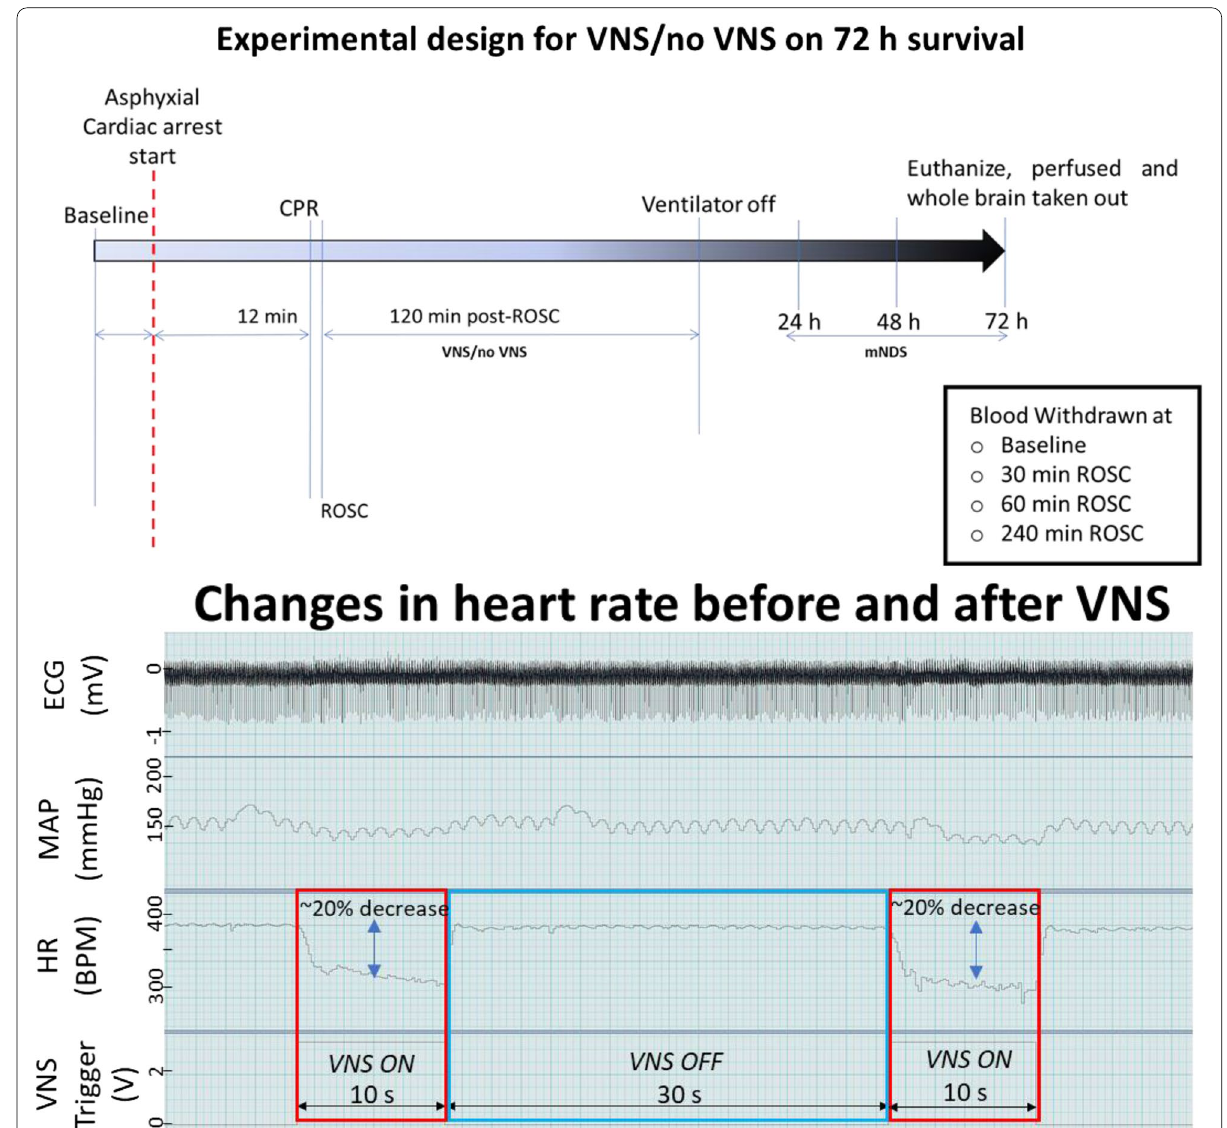
Fig. 1 The experimental design for No VNS/VNS after 12 min asphyxial cardiac arrest and resuscitation on 72 h survival (Upper panel). Changes in heart rate before and after VNS indicating 15–20% reduction in basal heart rate as a threshold (Lower panel). (CPR ROSC return of spontaneous circulation; tVNS =